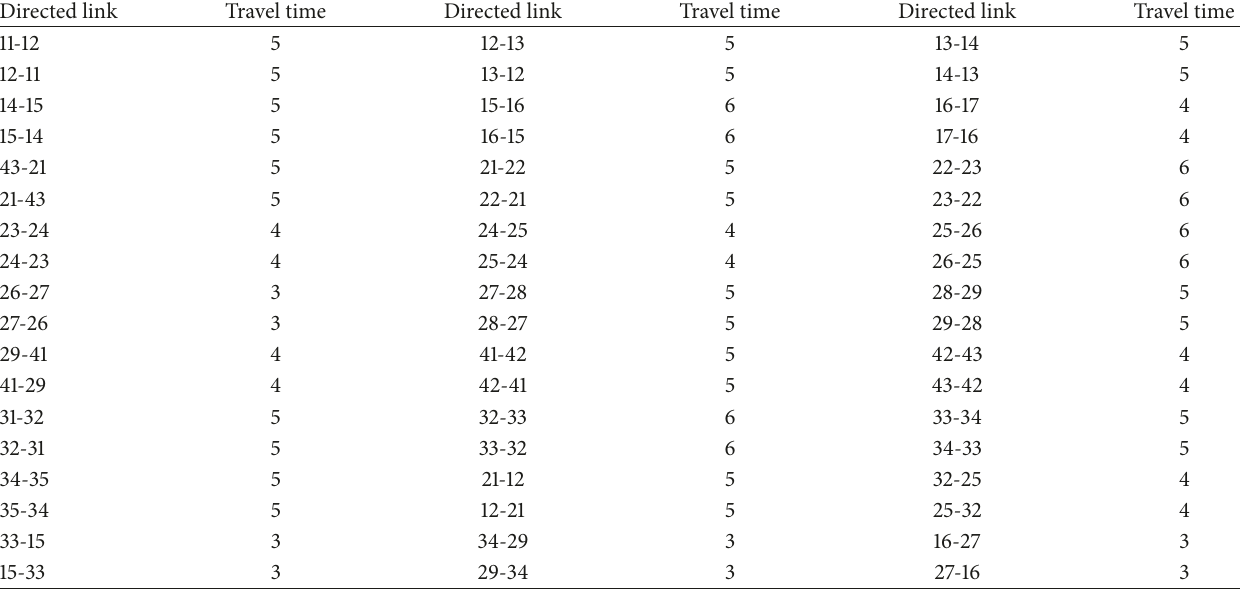
Table 1: The travel time of each link without overload delays (min).